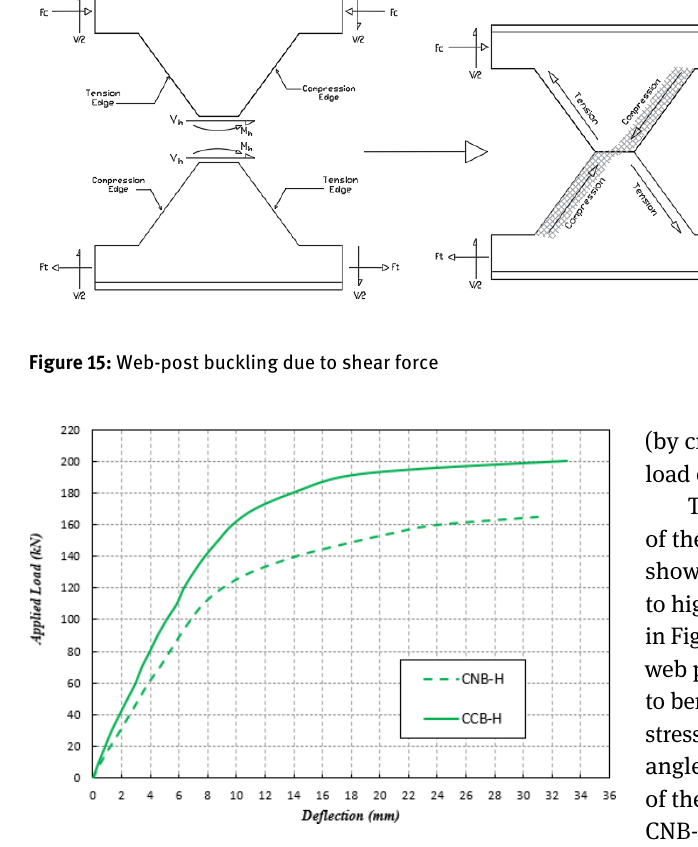
Figure 16: Load-deflection curve of Specimens CNB-H & CCB-H